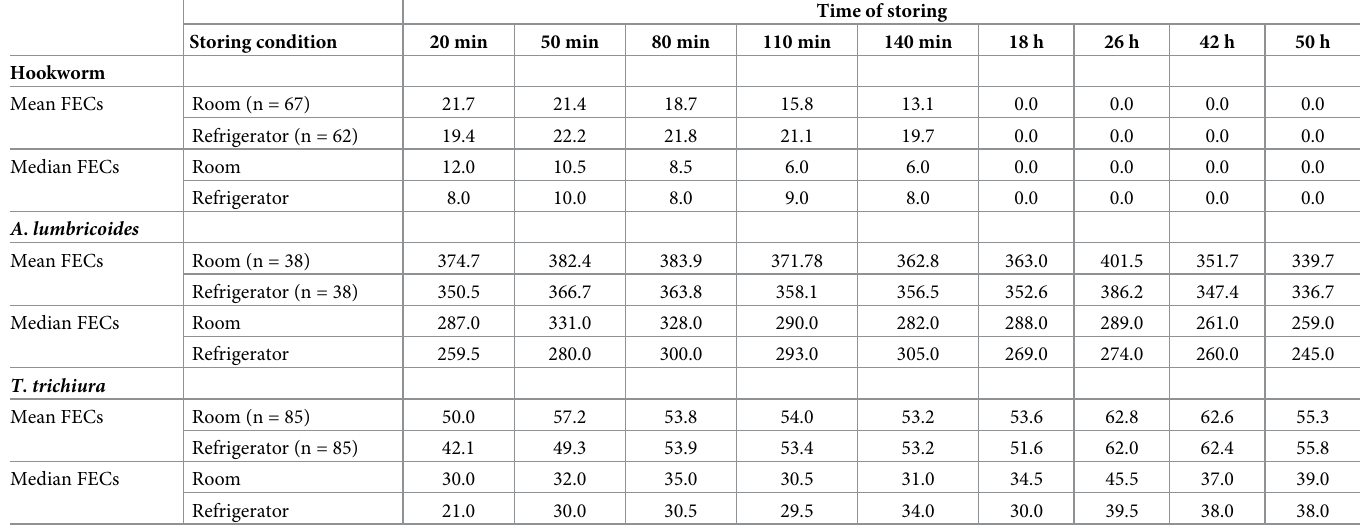
Table 2. Kato-Katz storing experiment: Results for hookworm, Ascaris lumbricoides and Trichuris trichiura . FECs = fecal egg counts, A . lumbricoides = Ascaris lum- bricoides , T . trichiura = Trichuris trichiura , min = minutes, h = hours.